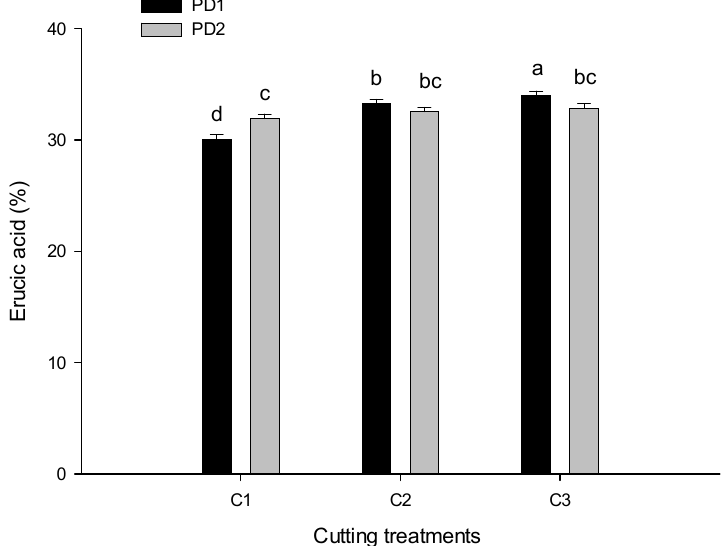
Figure 3. The interactive effect of planting density and cutting treatments of Erucic acid (%) for canola seed. Vertical bars represent Standard Error. Note: Cuttings (C): no-cut (C 1 ), cutting (C 2 ), grazing (C 3 ); Planting density (PD): 20 plants m − 2 (PD 1 ), 40 plants m − 2 (PD 2 ) Table 7. Erucic acid (%) canola as affected by cutting treatments, nitrogen levels and application timings under varying planting densities.